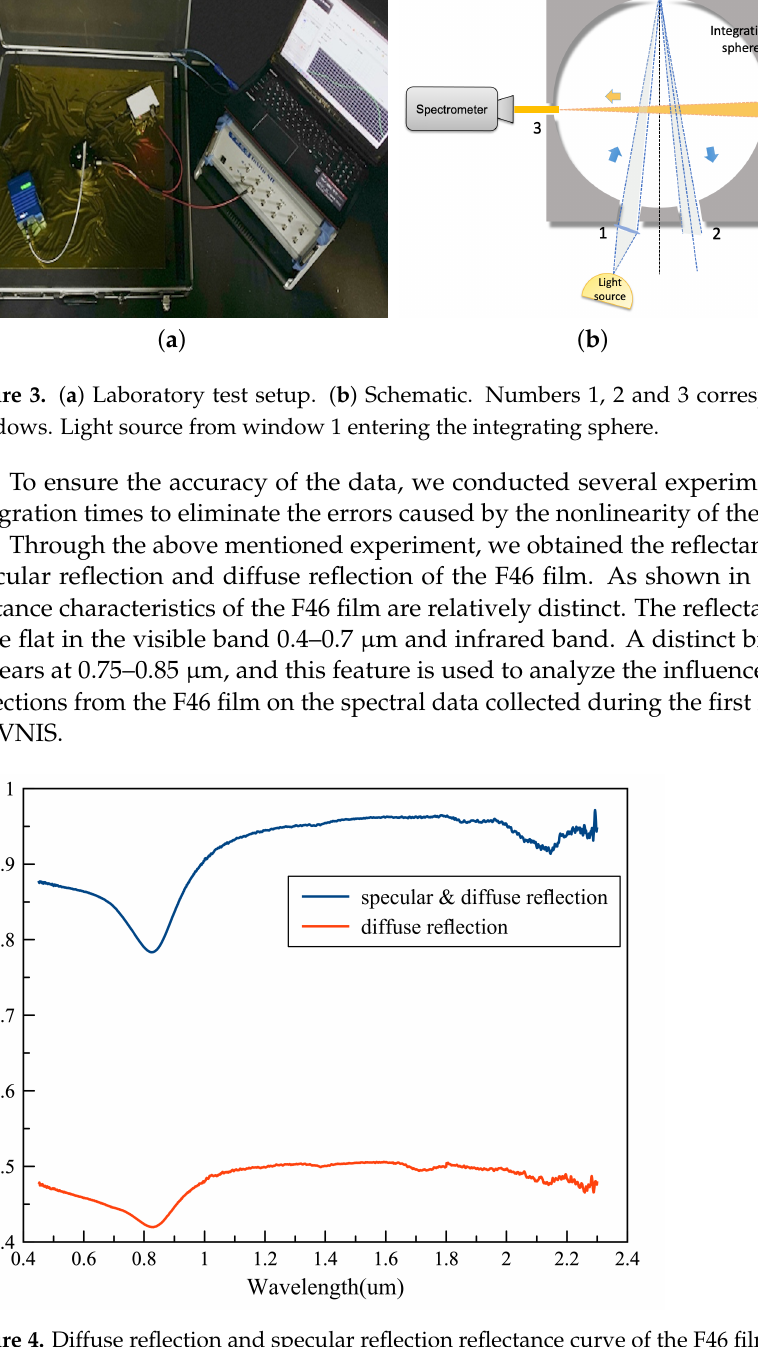
Figure 4. Diffuse reflection and specular reflection reflectance curve of the F46